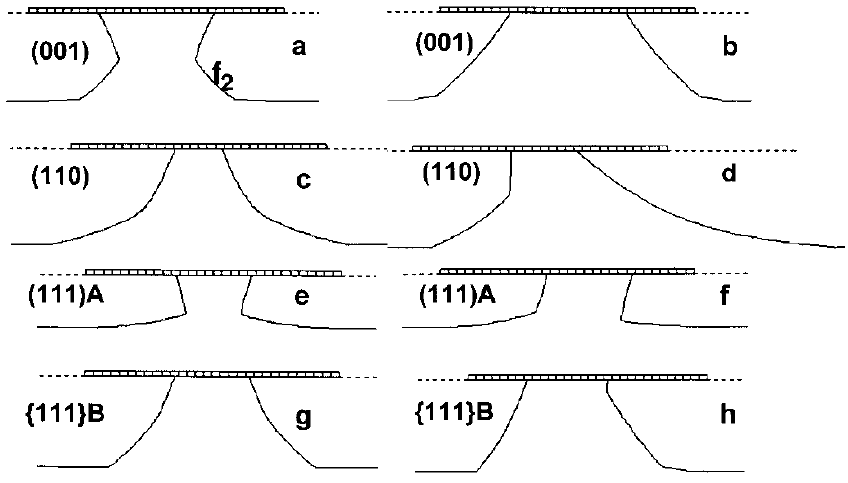
For various surfaces the angle C A takes the following values: (a) C A ¼þ 45 (cid:3) , (b) C A ¼(cid:1) 45 (cid:3) , (c, e, g) C A ¼ 0 (cid:3) , (d, f, h) C A ¼(cid:1) 90 (cid:3) .